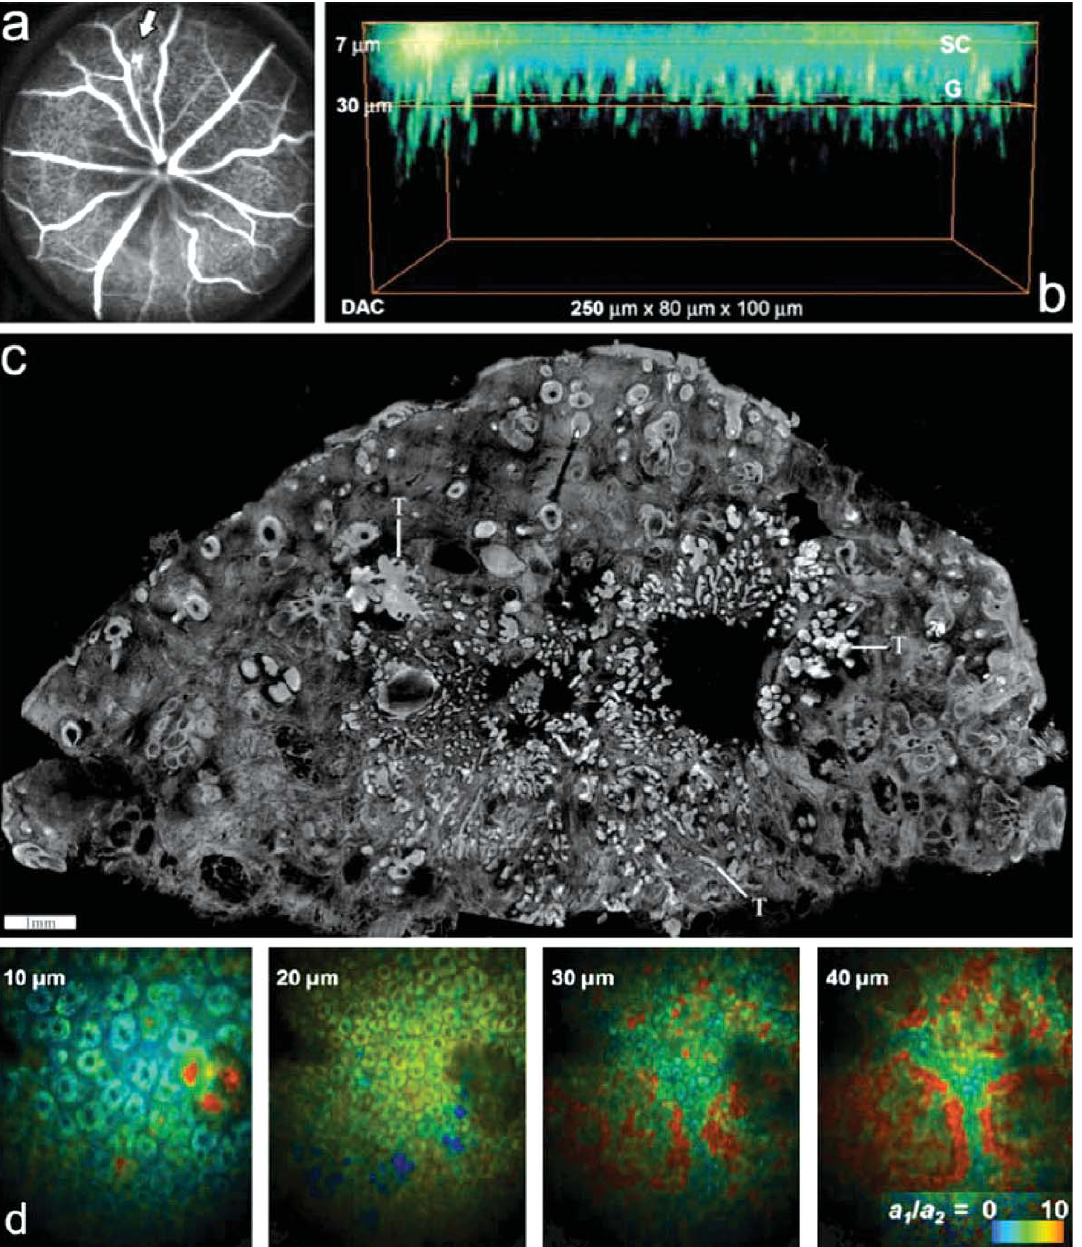
Fig. 2. a: Neovascularization in a mouse model (with fluorescein angiography). Image taken in vivo with a Heidelberg Engineering HRA I scanning laser ophthalmoscope. Arrow points to a well-defined lesion [110]. b: Microscopic imaging of the skin of a transgenic mouse model with GFP expression in the footpad. In vivo image taken with 10-mm diameter, dual-axis confocal (DAC) microscope [111]. c: Confocal mosaic of a micronodular basal cell carcinoma (BCC) obtained ex vivo . Individual images (430 by 430- (cid:1) m field of view) were combined to create a large image of excised tissue with a 10- to 20-mm field of view. Small tumor nests (T) are shown as bright spots. Fluorescence emission detected from acridine orange-stained nuclei using a VivaScope 2000 by Lucid, Inc. Scale bar indicates 1mm [112]. d: Multiphoton microcopy of intrinsic fluorescence contrast from healthy human skin at various depths. The false coloring shows the ratios of the amplitudes ( a 1 /a 2 ) of the double-exponential fluorescence lifetime decay, a presumed indicator of metabolism